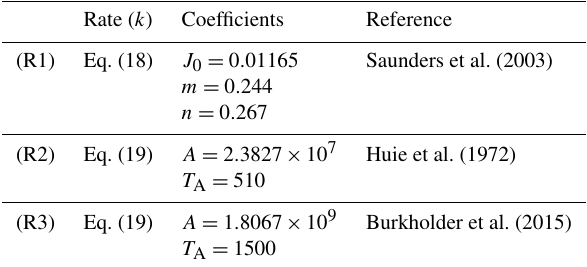
Table 1. Reaction rate parameters for the photostationary NO-NO 2 - O 3 mechanism. Units are kmol, m 3 , s, and